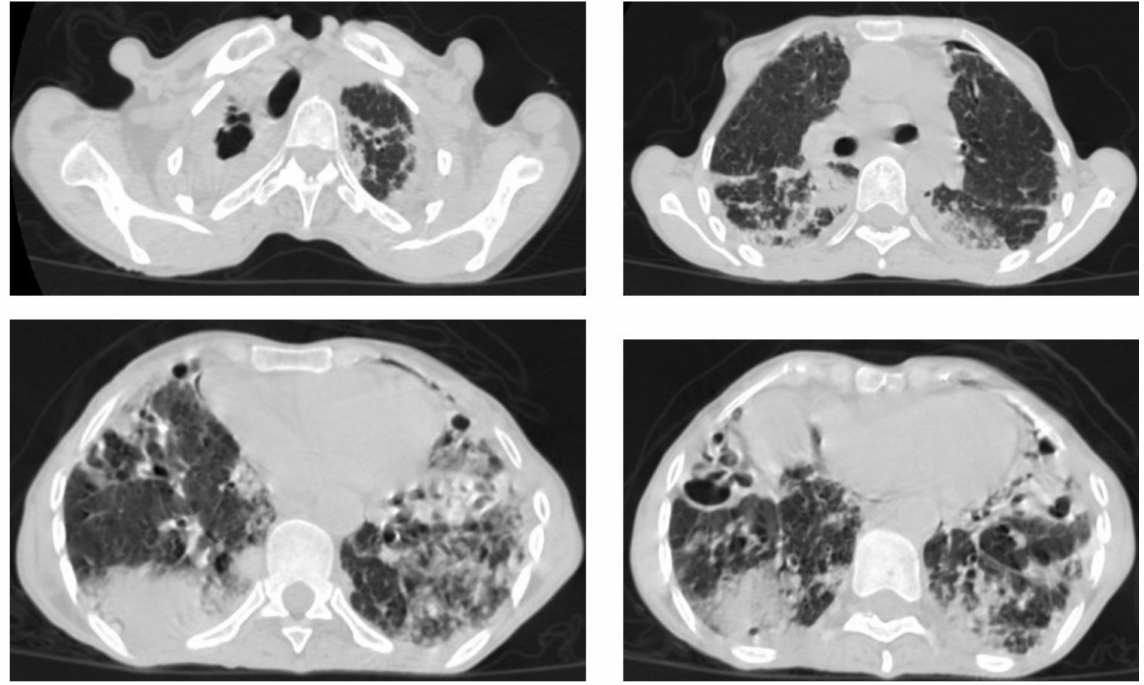
Figure 9. Old reactive TB with superimposed infection in a 75-year-old female with chronic cough and no history of previous medication. Selected axial images of lung CT show prominent fibrotic changes with scarring traction bronchiectasis and decreased volume in the apical and posterior segment of the upper lobes and architectural distortion of the lung parenchyma caused by cystic bronchiectasis predominantly involve bilateral lower lobes, ligula, and right middle lobe. Patchy consolidative areas and ground glass opacities are signs of active infection.